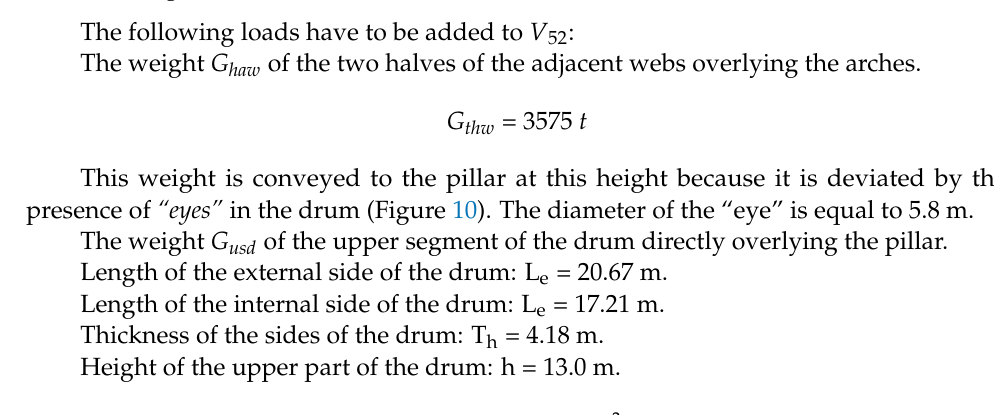
Figure 10. The web overlying the pillar and two half-webs above the adjacent